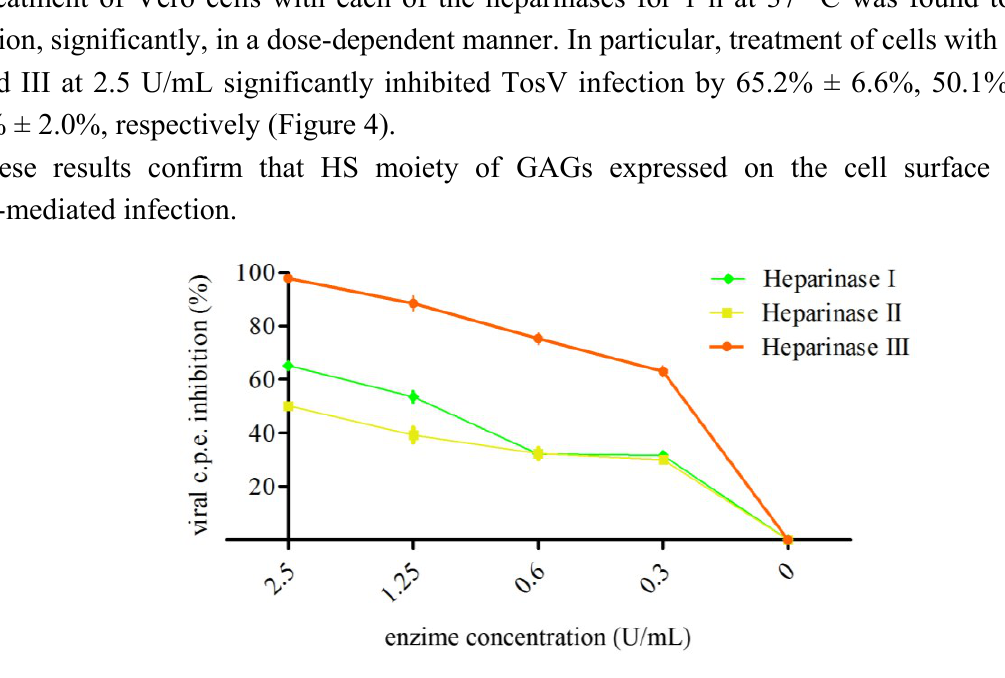
Figure 4. Modulation of infectivity by enzyme treatment of cell surface GAGs. GAGs were enzymatically removed from the cell surface of Vero cells by treating the cells for 1 h